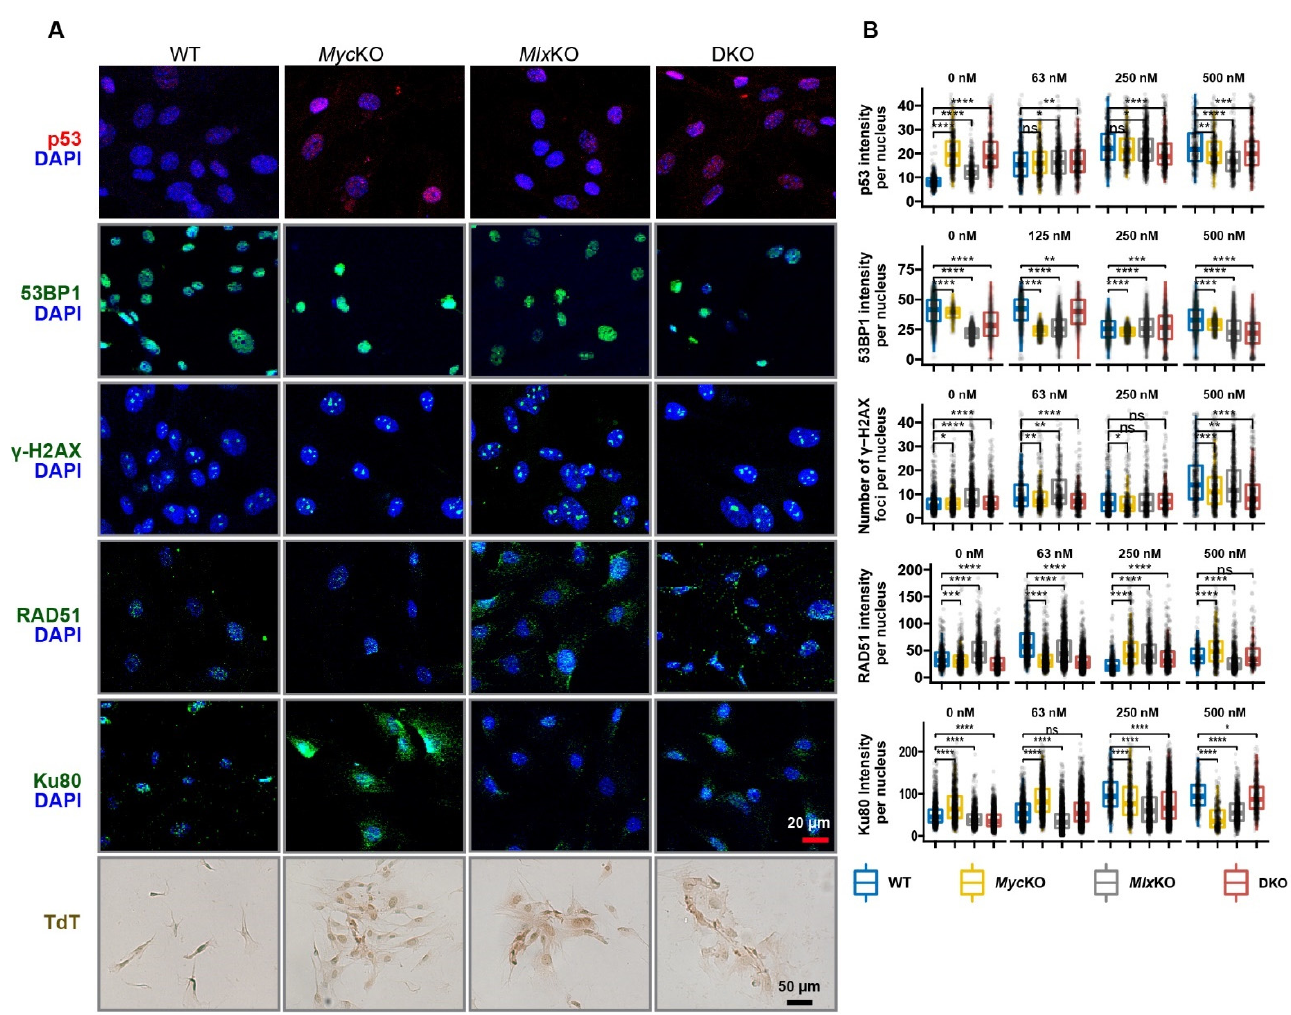
Figure 6. DNA damage response/repair defects in KO MEFs: ( A ) Baseline expression of DNA damage recognition/repair proteins detected by immunohistochemical staining in the indicated primary MEFs. A TdT/TUNEL assay was used as an alternate way to identify double-stranded breaks (DSBs). ( B ) Response of the proteins shown in ( A ) to DSBs induced by etoposide. MEFs were plated as described in ( A ), allowed to attach for 24 h, and then exposed to the indicated concentrations of etoposide for 16 h, fixed, and stained for the indicated proteins. Staining intensities and/or numbers of foci were then quantified for each drug concentration and compared to untreated cells. For each concentration of etoposide, images from at least ~700–800 individual cells were quantified using ImageJ [14] . See Figure S16 for the results shown in panel B depicted as dose–response curves. * p < 0.1, ** p < 0.01, *** p < 0.001, **** p < 0.0001.